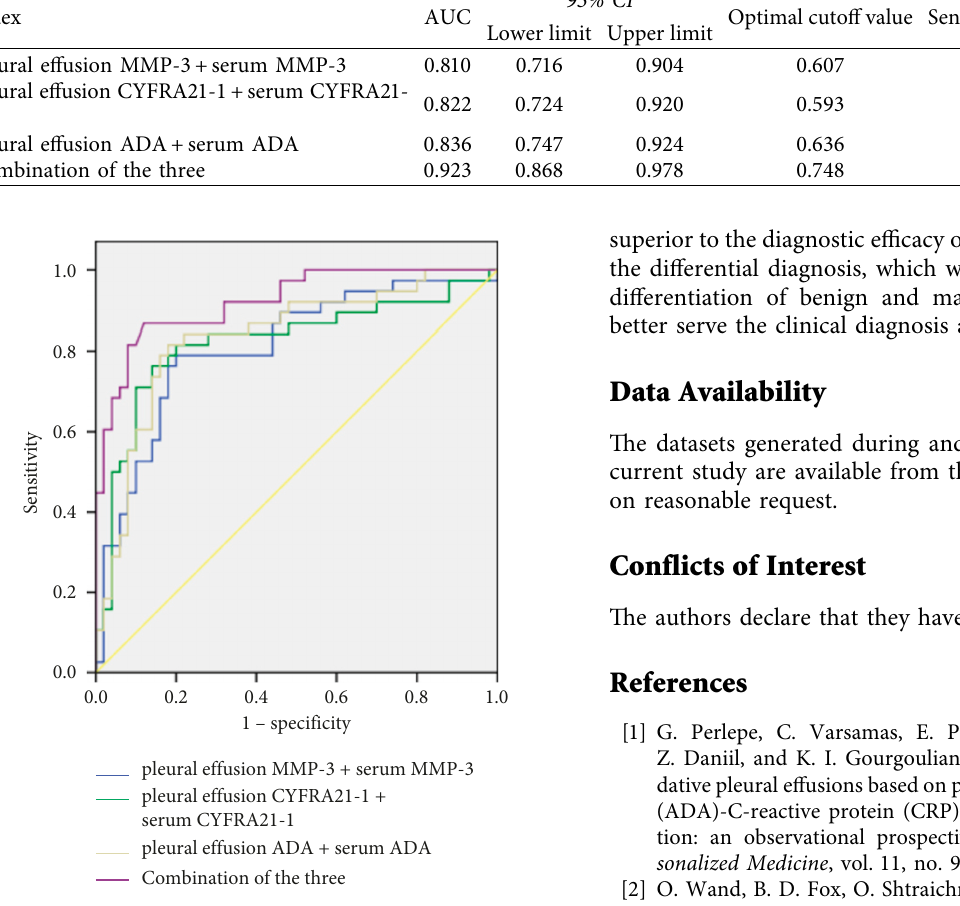
Figure 3: ROC curve of pleural effusion and serum MMP-3, CYFRA21-1, and ADA in the differential diagnosis of